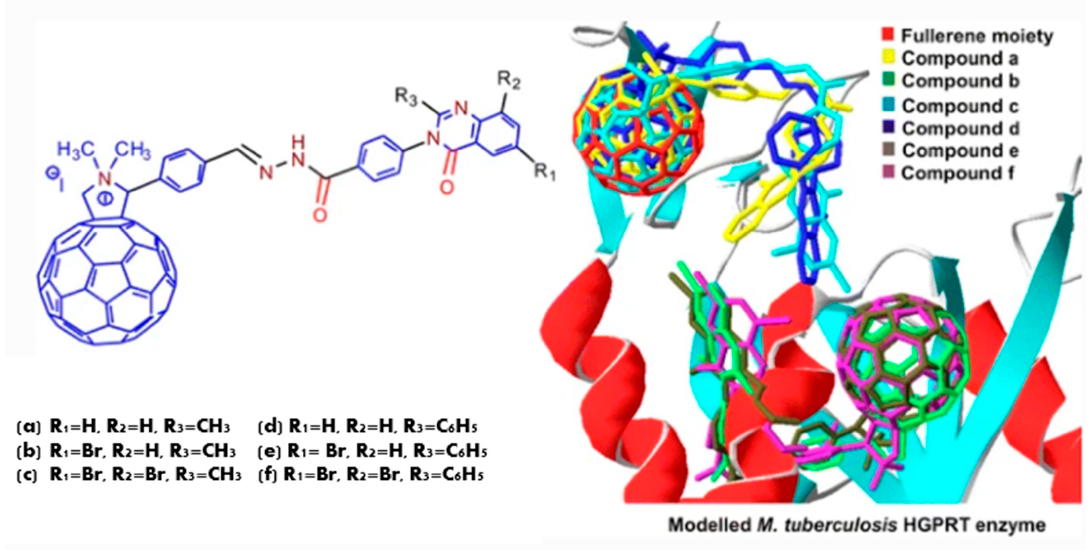
Figure 2. Compound 14 docked into the binding site of M. tuberculosis hypoxanthine-guanine phosphoribosyl transferase enzyme [15].